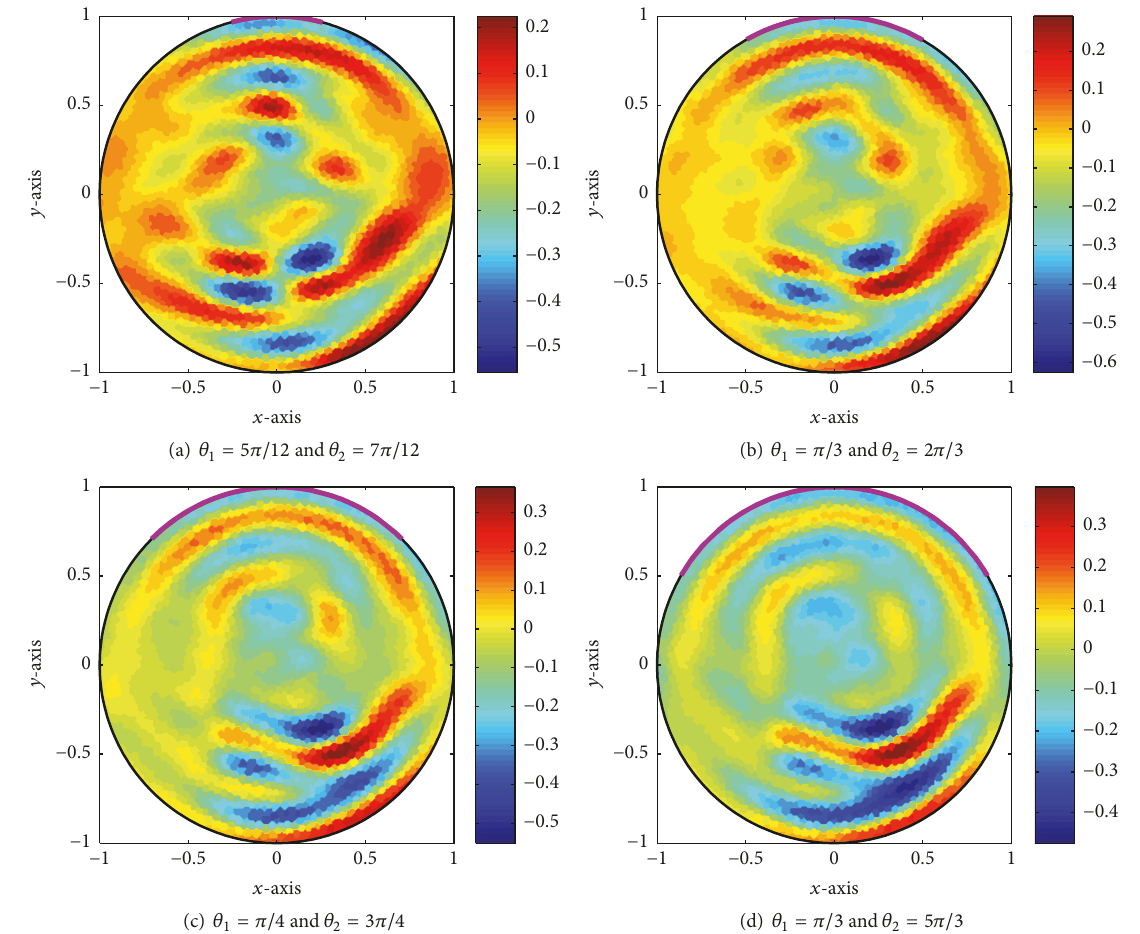
Figure 4: Maps of E ( z ;𝐹) for Γ 1 . Violet-colored solid line describes the range of incident directions.